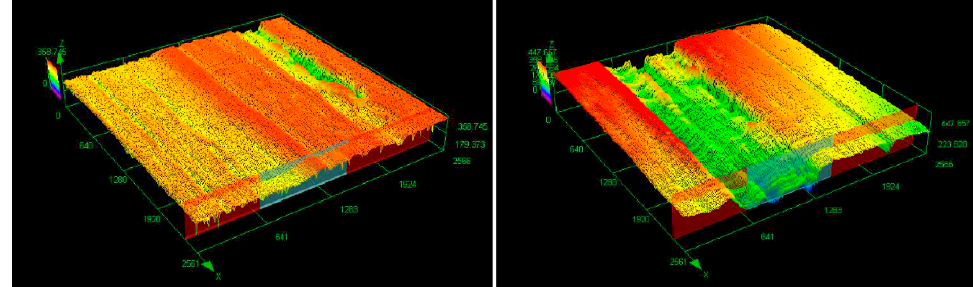
Figure 2. 3D image of oak wood surface before ( left ) and after 2 years of weathering ( right )—confocal laser scanning microscopy (area of 800 × 800 μ m).